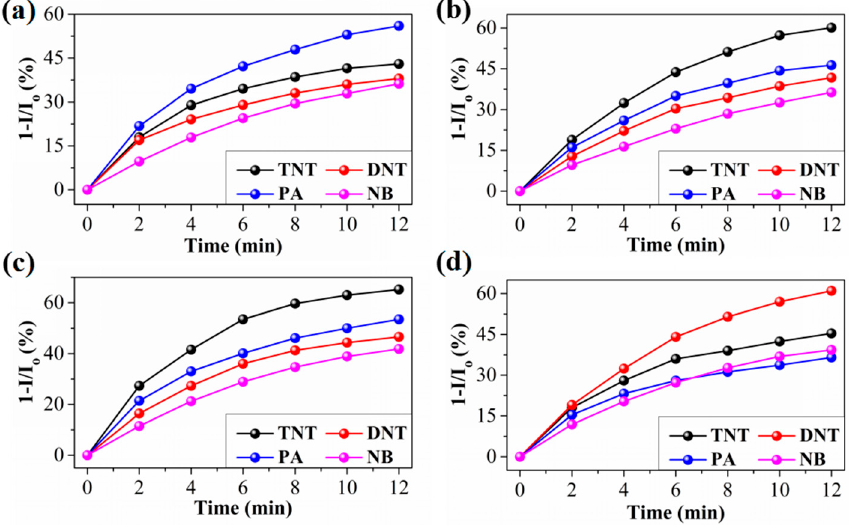
Figure 5. Variation of the quenching percentage for ( a ) PU-1C, ( b ) PU-1CH, ( c ) PU-1L and ( d ) PU-1TL as a function of the exposure time to the saturated air of TNT, 2,4-dinitrotoluene (DNT), picric acid (PA) and nitrobenzene (NB) at room temperature.